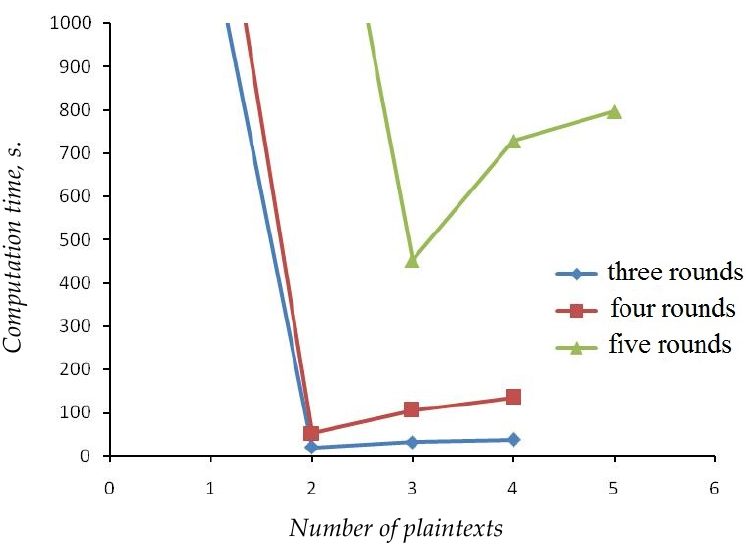
Figure 6. Search complexity with different numbers of Magma rounds.